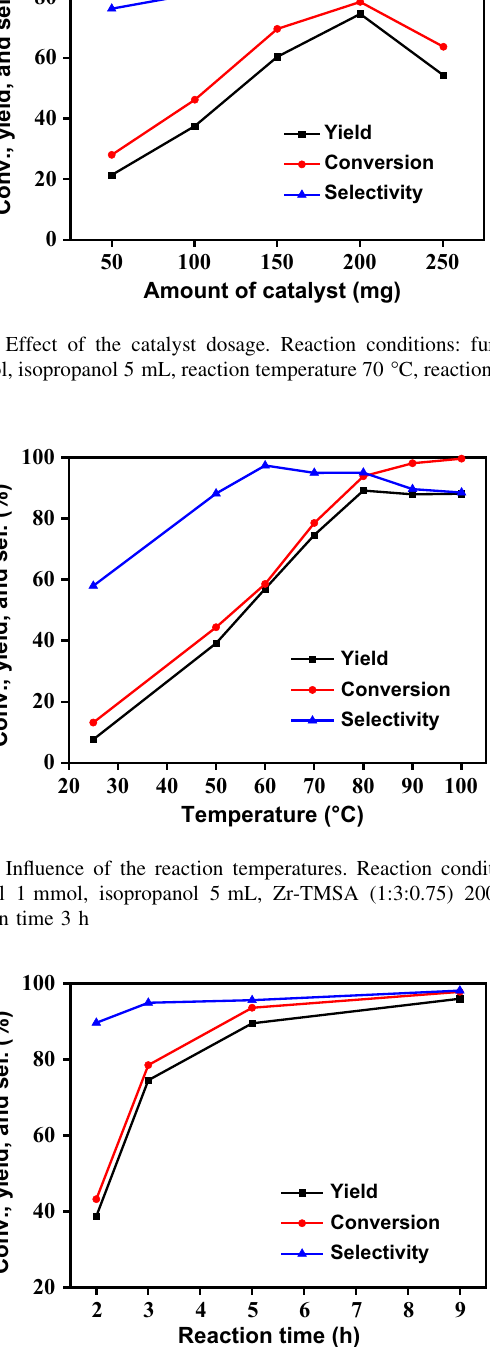
Fig. 1 Characterization of the as-prepared Zr-TMSA catalyst by SEM ( a ), TEM ( b ), powder XRD pattern ( c ), and TG-DTG analysis ( d )